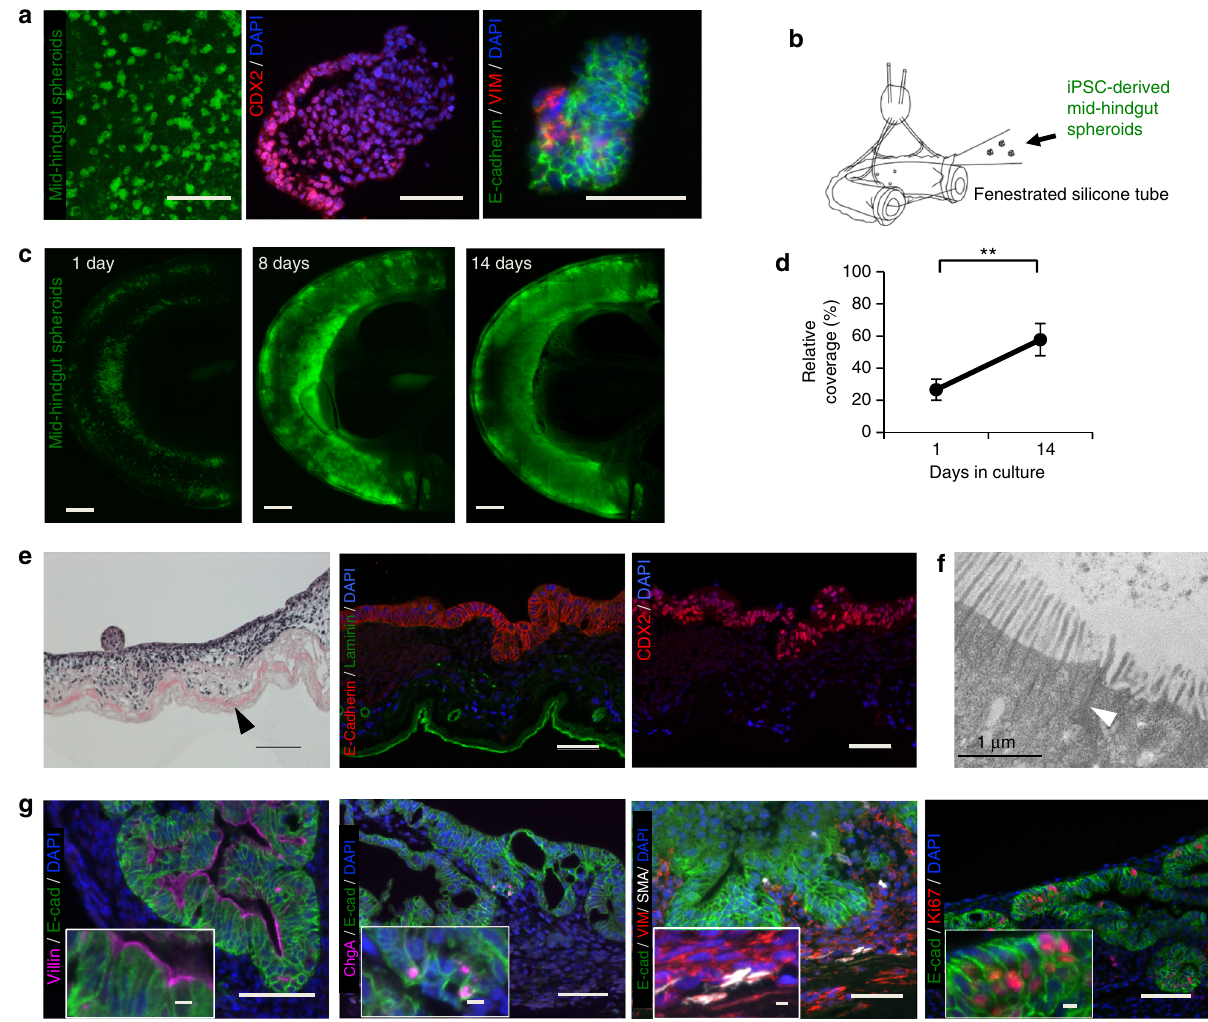
Fig. 2 Cell seeding and whole-organ culture of decellularized rat intestine. a Fluorescence micrographs of GFP-positive human iPSC-derived mid-hindgut spheroids budding out from 2-dimensional culture of de fi nitive endoderm on a tissue culture plate ( left ), a spheroid consisting of CDX2-positive cells ( middle ), a spheroid stained with E-cadherin and vimentin demonstrating cells of both epithelial and mesodermal fate ( right ). Scale bars , 1 mm ( left ) and 100 µ m ( middle / right ). b Schematic of seeding mid-hindgut spheroids into the intestinal lumen of a rat intestinal scaffold. c Whole-mount fl uorescence micrographs showing GFP-positive mid-hindgut spheroids proliferating to cover regions of the intestinal wall over the culture period. Scale bars , 2 mm. d Quanti fi cation of scaffold luminal coverage using visualization of GFP-positive signal at 1 day and 14 days of spheroid culture ( n = 3). Error bars , mean ± s.d. of experimental values. ** P < 0.01, Student ’ s t test. e Hematoxylin and eosin staining ( left ) and fl uorescence micrographs of the intestinal epithelium engrafted on rat intestinal scaffold at day 28 of culture in vitro. E-cadherin-positive epithelial cells form a monolayer on the luminal surface of the intestine ( middle ) and express CDX2 ( right ), indicating intestinal lineage. Scale bars , 100 µ m. f Transmission electron micrograph of regenerated intestinal epithelium on an intestinal scaffold. Presence of microvilli and cellular junctions ( white arrowheads ) are identi fi ed. g Characterization of iPSC- derived epithelium shows that villin is predominantly expressed on the apical surface of the epithelium, indicating enterocytes ( left ), a subset of cells express chromogranin A, indicating enteroendocrine cells ( middle left ), a supportive mesenchyme containing smooth muscle cells stains positive staining for vimentin and SMA ( middle right ) and a proliferative cell population is indicated by positive Ki67 staining ( right ). Scale bars , 100 µ m; 10 µ m ( insets